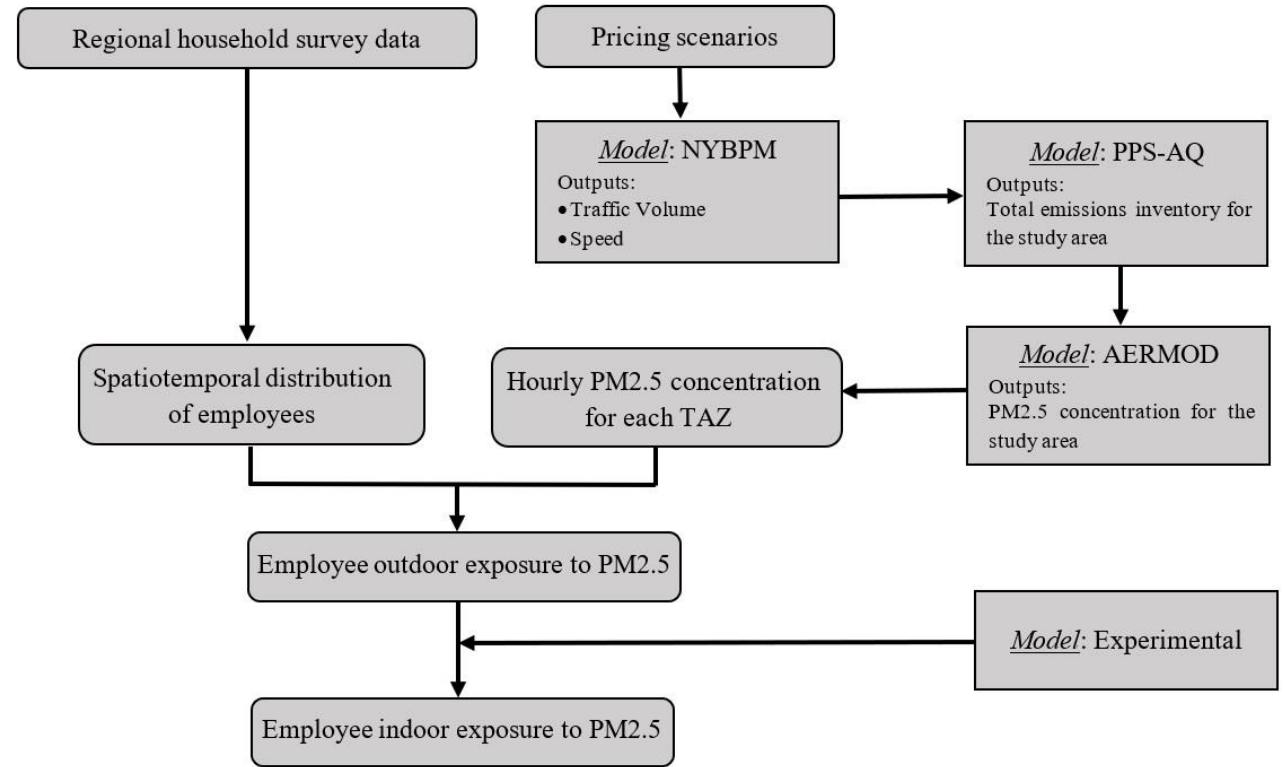
Figure 1. Integrated modeling framework.